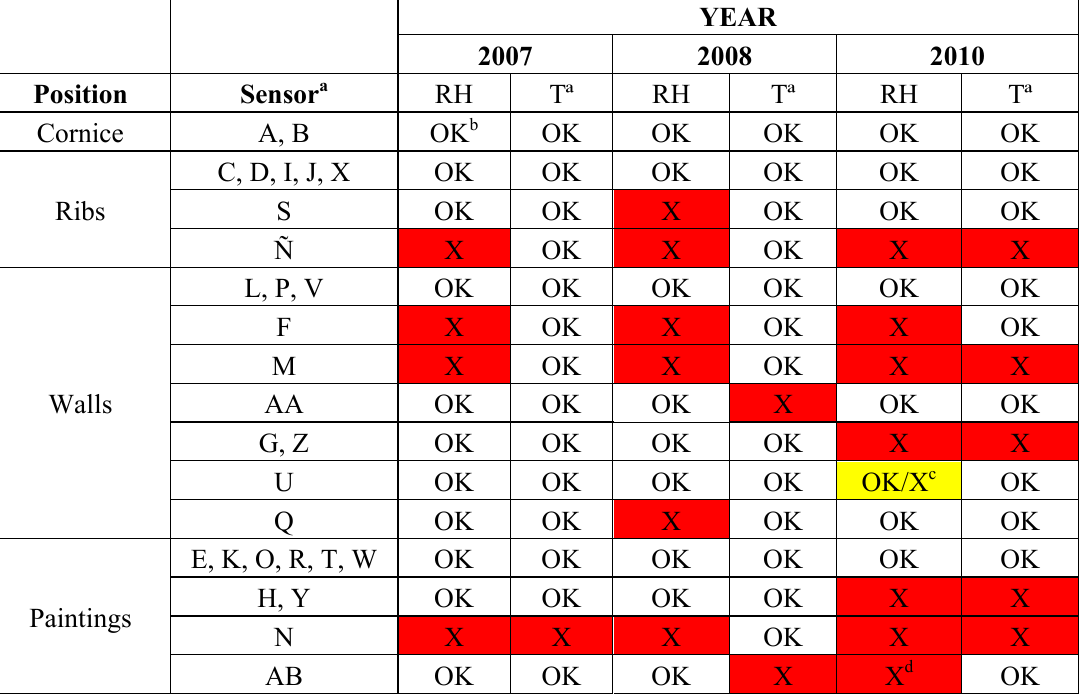
Table 1. Sensors providing RH and Tª data appropriate for the multivariate statistical